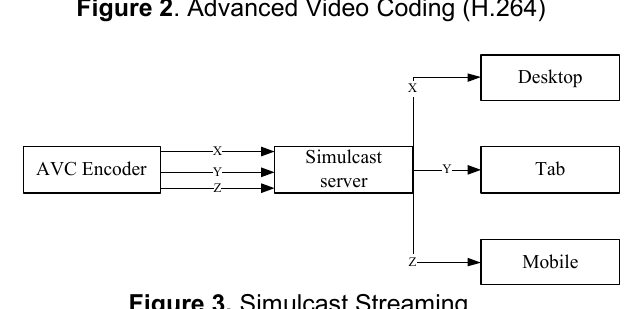
Figure 3. Simulcast